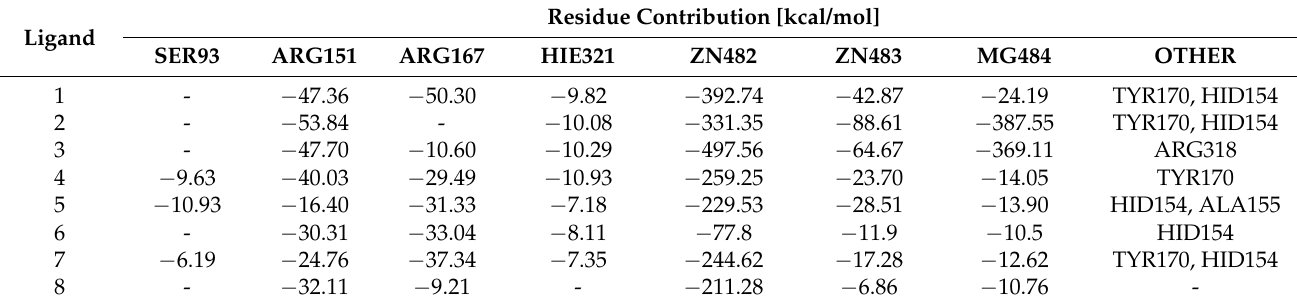
The amino acids involved in ligand binding are presented in Figure 5, as a repre- sentative from clustering the trajectories. In each case, negatively charged atoms form ionic interactions with metal ions, Zn cation or, in the case of imidodiphosphate, with Mg cation. There are also a number of interactions between the ligand and arginines or another residue in their vicinity, mainly being hydrogen bonds and electrostatic interac- tions. All these interactions resulted in overall negative ∆ ( ∆ ) G values obtained through both TI and MM/GBSA studies. There is also a strong influence of negatively charged phosphate groups (total charge -4), which when combined with the divalent metal ions in the vicinity (Mg 2+ and two Zn 2+ ) have influence on the energy of binding. The fact that hypophosphate binds weaker than the natural substrate derives straight from the Table 3. Amino acids with contribution to substrate binding energy lower than − 5 kcal/mol. fewer number of possible interactions. As hypophosphate lacks a bridging atom, which in every case but methylenediphosphonic acid is electronegative, the number and strength of potential interactions are lower and so is the hydrophobic effect from the carbon atom from methylenediphosphonate. In most cases, ligands have limited influence on the fluctuation of residues in the active site (Figure 6). The only region that seems to be changed by ligand binding is between 370 and 430, which changed its spatial structure in the case of hypophosphate and alendronate. The origin of this phenomena may derive from